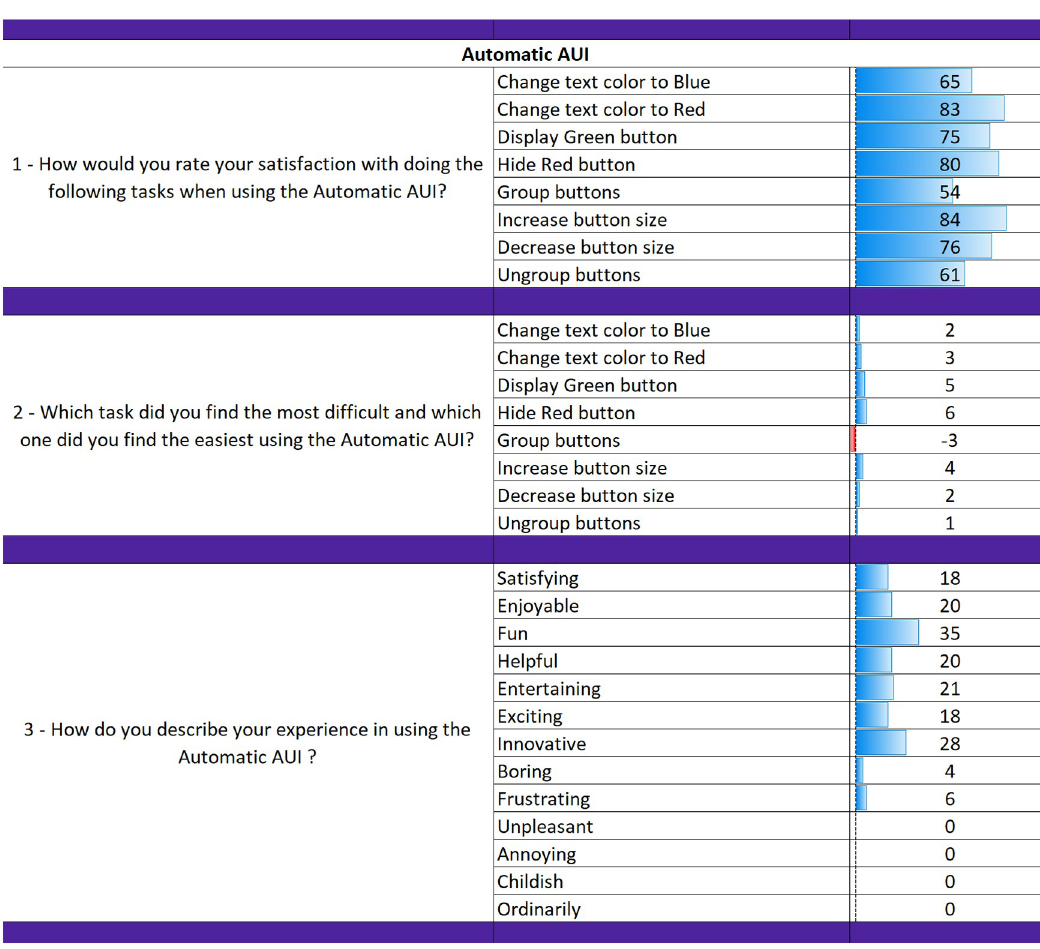
Fig 19. Questionnaire results for the Automatic